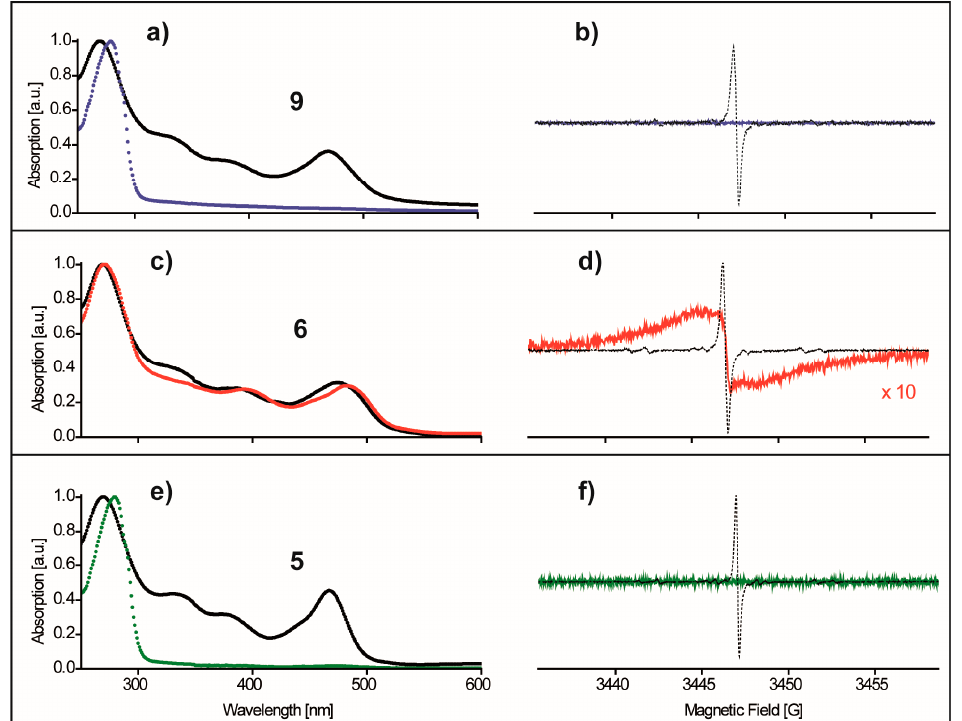
Figure 4. The incubations of 9 (blue), 6 (red) and 5 (green) with cysteine-free YopO-WT. The spectra shown have been recorded after size exclusion chromatography. Panels ( a) , ( c) , ( e ): normalized UV/Vis spectra of the protein solutions in juxtaposition with 20 µM buffer solutions of the pure trityl compounds 9 , 6 , and 5 (black). Panels ( b ), ( d ), ( f ): corresponding room temperature cw X-band EPR spectra overlaid with the spectrum of the free label (dashed black line) for the sake of comparison. According to the obtained UV/Vis and EPR spectra, excess label 9 (Figure 4a,b, blue trace) and 5 (Figure 4e,f, green trace) were successfully separated from the cysteine-free YopO-WT protein as seen by the absence of the characteristic trityl UV/Vis band at ~467 nm (black traces in Figure 4a,e), the